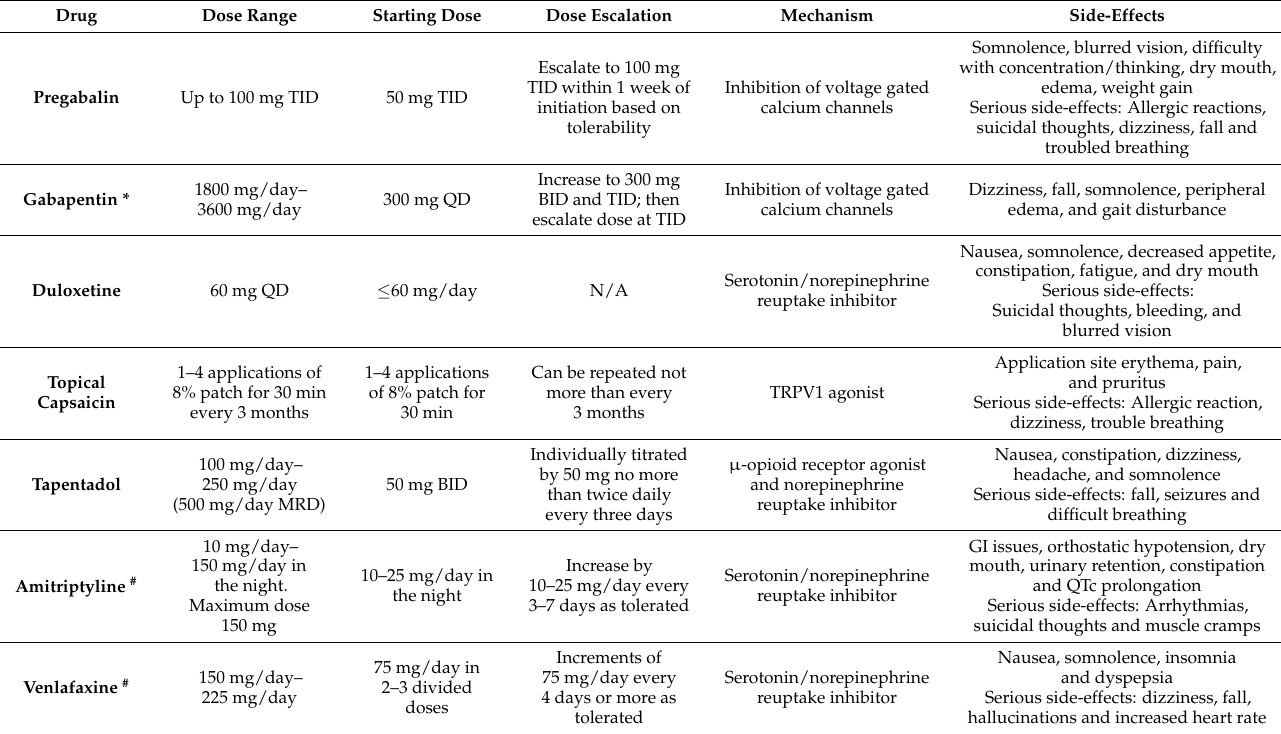
Table 2. Pharmacotherapies for painful diabetic